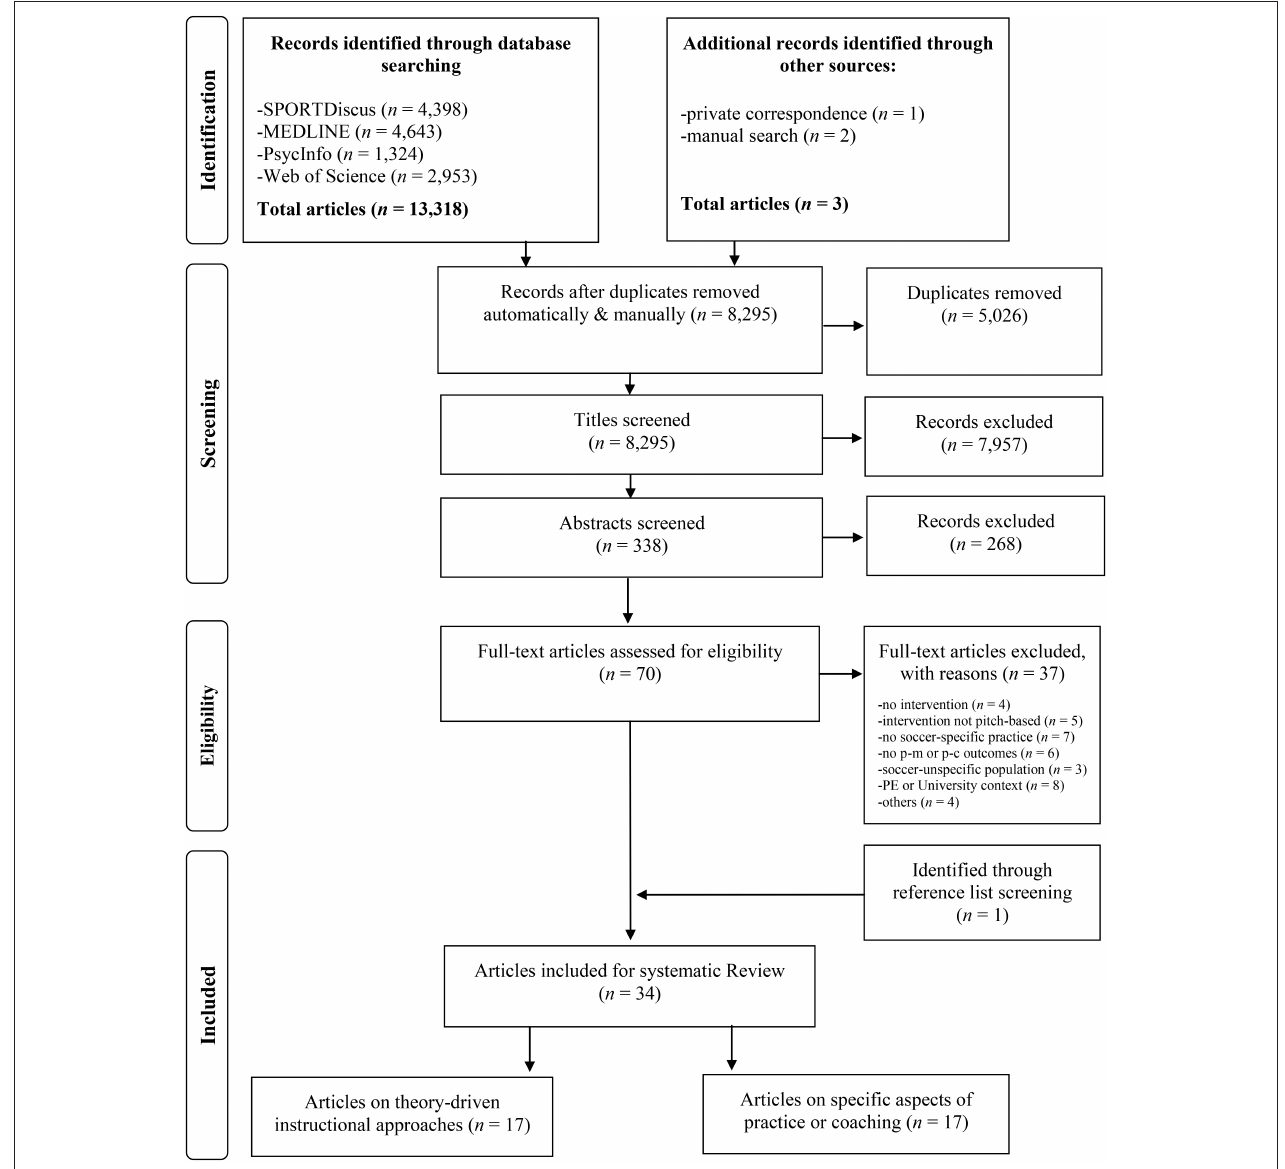
FIGURE 1 | PRISMA flowchart for the documentation of the systematic search process. Notes: The 17 articles on theory-driven instructional approaches include 18 individual studies. PE, Physical Education; p-c, perceptual-cognitive; p-m,